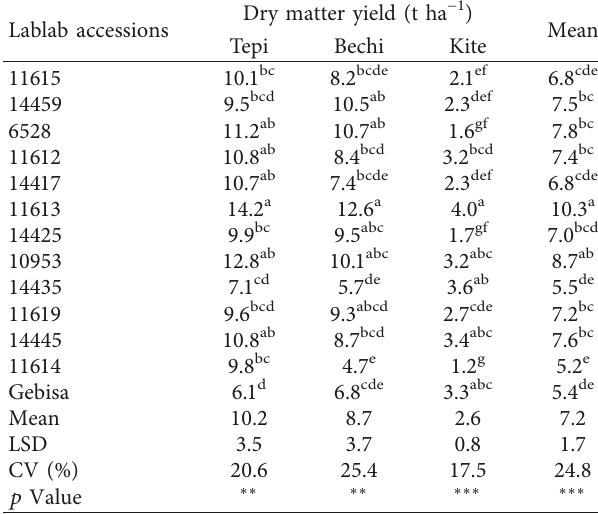
Table 6: Number of leaves per plant of lablab accessions at forage harvesting stage of 50% flowering at Tepi, Bechi, and Kite testing sites.